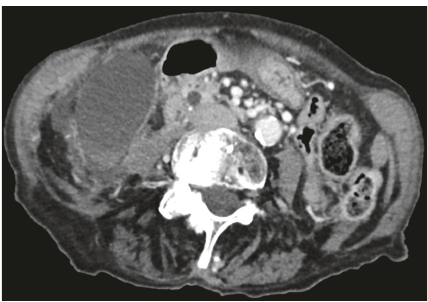
Figure 4: Laparoscopic